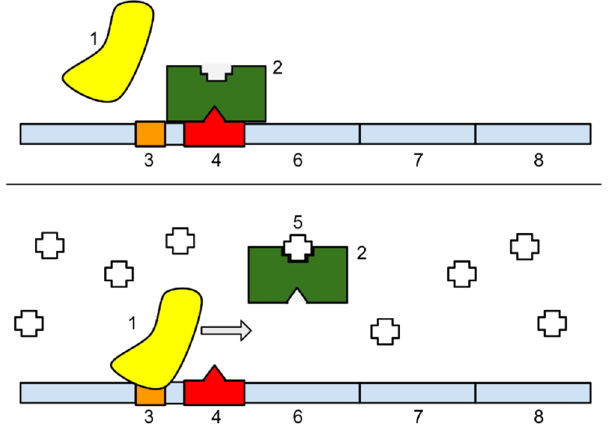
Figure 3. Lac operon (top) repressed; (bottom) active: 1 = RNA polymerase; 2 = repressor; 3 = promoter; 4 = operator; 5 = Lactose; 6 = lacZ; 7 = lacY; 8 = lacA (Creative Commons Attribution—Share Alike 3.0 credit T A Raju).